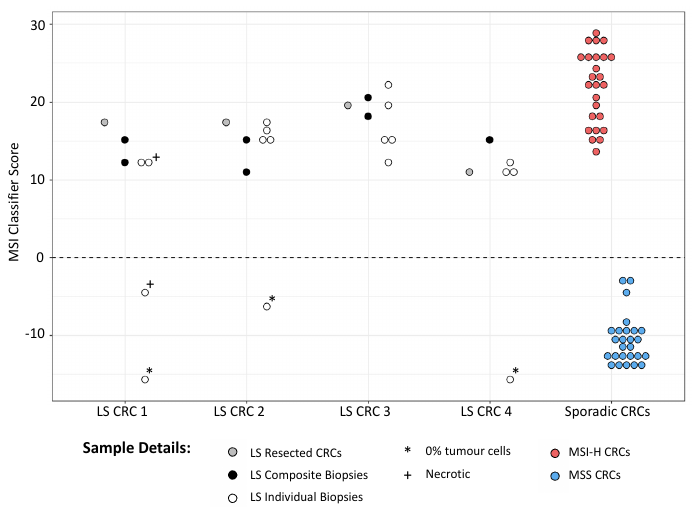
Figure 3. MSI classification of CRC samples from LS patients. MSI scores from CRCs, associated endoscopic biopsies, and composite biopsies from 4 LS patients are shown, along with scores from MSI-H and MSS tumours from the test cohort. Scores >0 are classified as MSI-H, scores <0 as